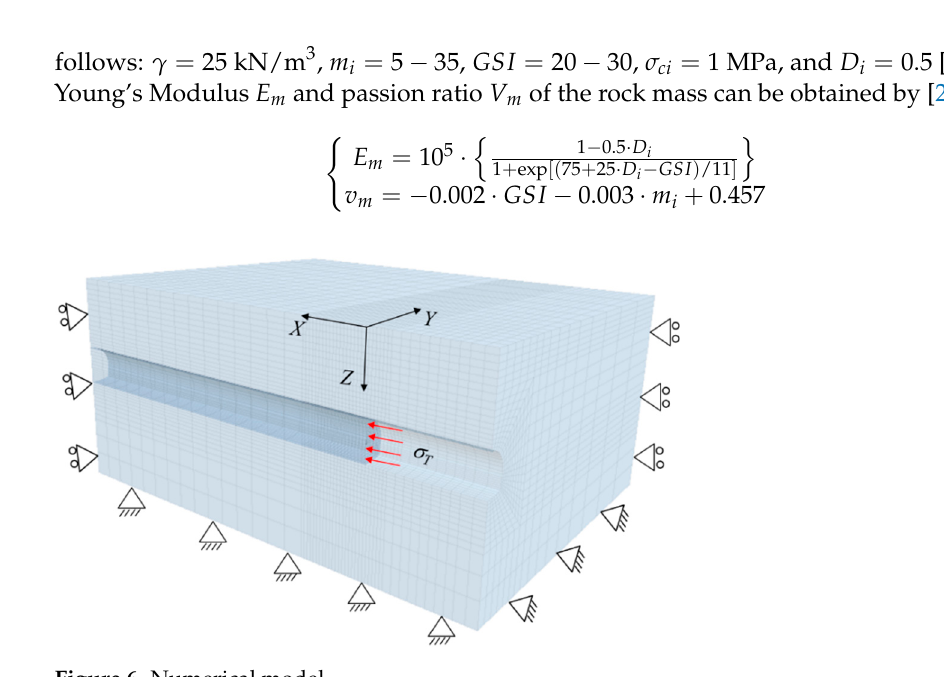
Figure 6. Numerical model.